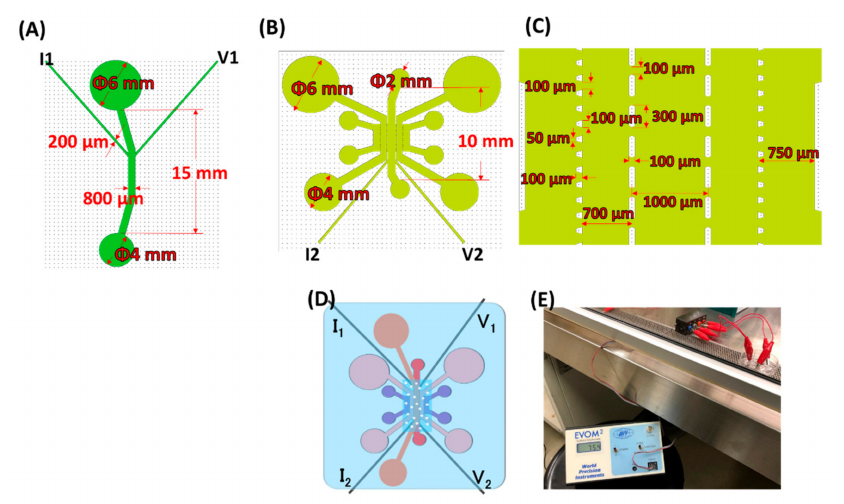
Figure A1. Dimensions of the microchannels for trans-epithelial electrical resistance (TEER) measurement. ( A ) Upper channel. ( B ) Lower channel. ( C ) Magnified view of ( B ), showing dimensions of multi-channels. ( D ) Top view of the assembled TEER device. ( E ) Experimental set-up for TEER measurement showing the connection between the microfluidic device and the EVOM